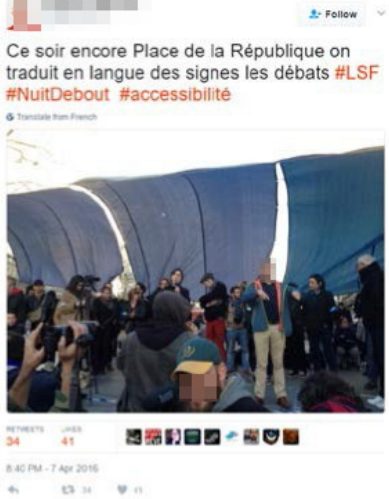
Figure 2. Tweet on #nuitdebout visualizing sign‐language translation. Note: We obtained the user’s consent to reprint the tweet; username and faces of depicted peo‐ ple were pixelated to guarantee anonymity.